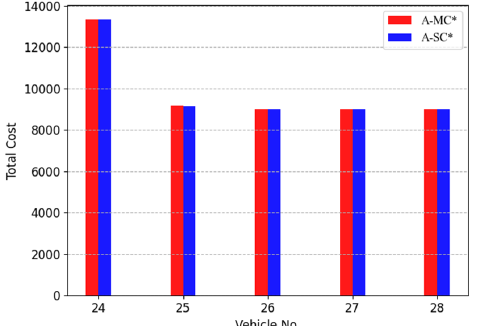
Fig. 3. Influence of different number of vehicles on total cost